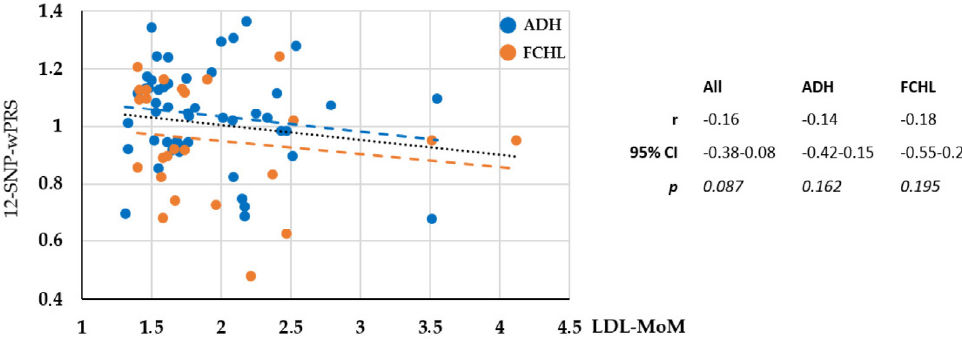
Figure 4. Correlation between the 12-SNP weighted polygenic risk score (wPRS) and the severity of the phenotype measured by the LDL-C. Multiple of median for LDL-C level (LDL-MoM). Non- parametric Spearman test.